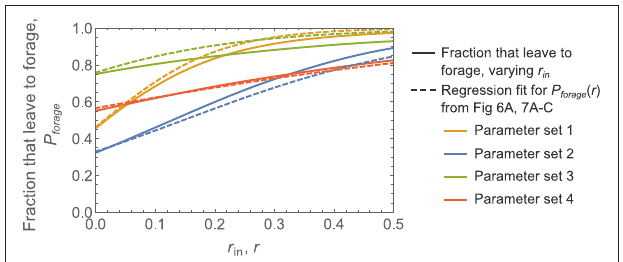
FIGURE 9 | Changes in the fraction of ants that leave the nest to forage with mean input interaction rate. Shown are simulation results for the fraction of ants that leave the nest to forage as a function of the mean input interaction rate r in (solid lines). These were obtained by performing multiple simulations with different values of r in , while other parameters remained the same. Rate regression fits for P forage ( r ), reproduced from Figures 6A , 7 , are shown for comparison; note that these simulations had fixed r in values and the different values of r shown here result from Poisson variability across ants in the experienced rate of interactions (number of contacts per second). Parameter sets 1, 2, 3, and 4 were taken from Figures 6A , 7A–C , to resemble the observations for colonies 1, 2, 3, and 4, respectively. Note that much of the difference between the curves for parameter set 3 is due to the added 5s post-decision time in the simulations of Figure 7B , which was not included when generating the fraction that leave to forage as a function of r in